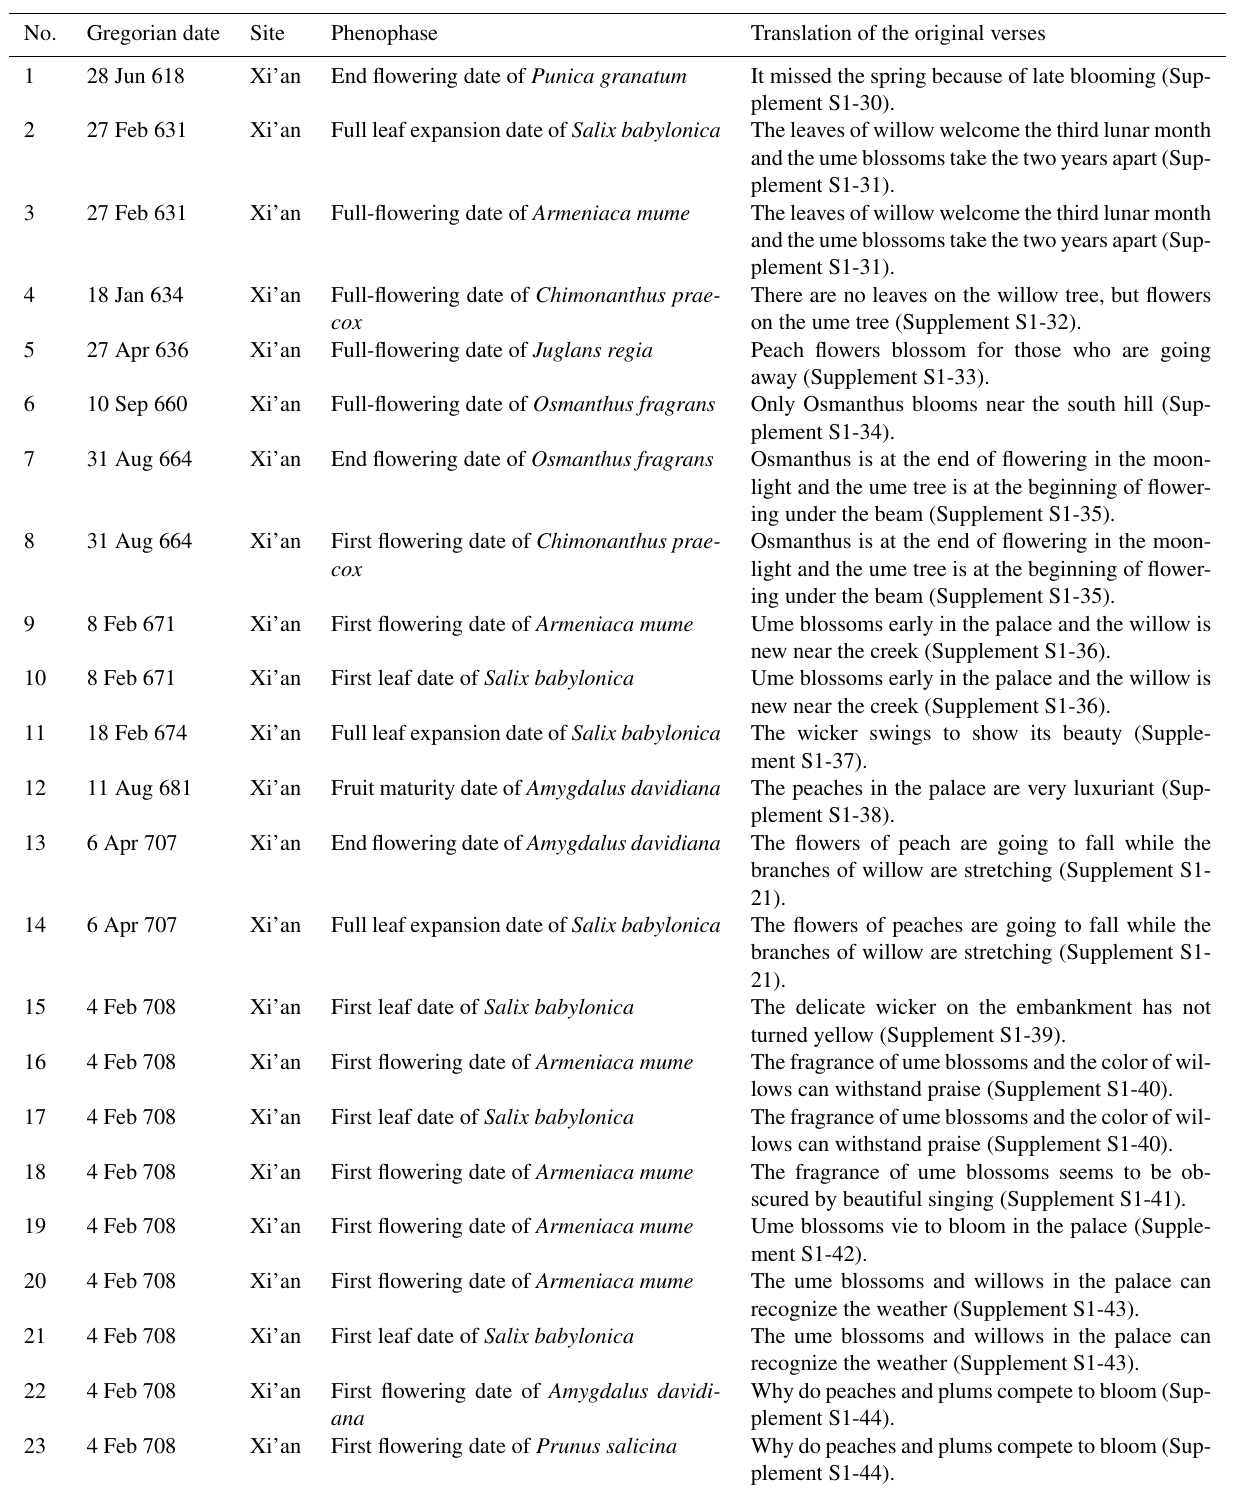
Table A1. Phenological records from poems used in the reconstruction of this